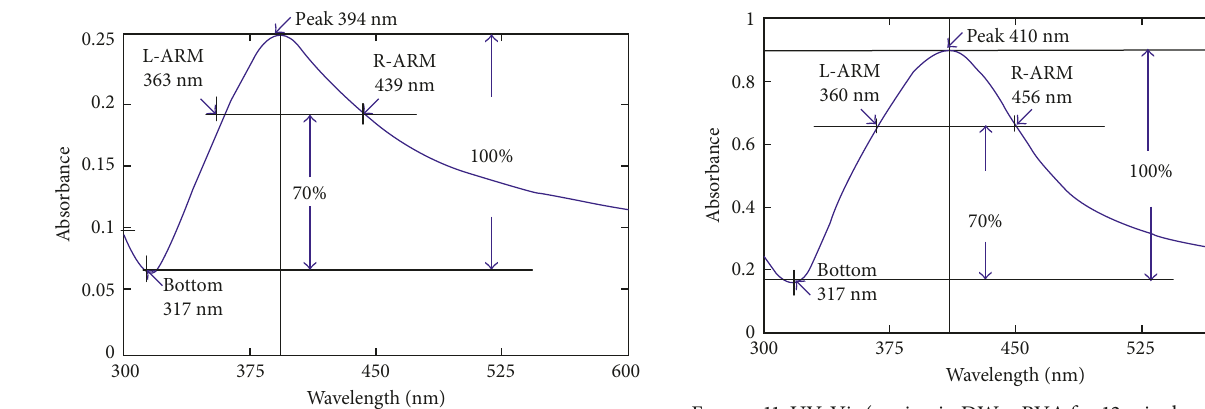
Figure 10: UV-Vis (arcing in DW for 6 min, band width at absorbance 70% height).